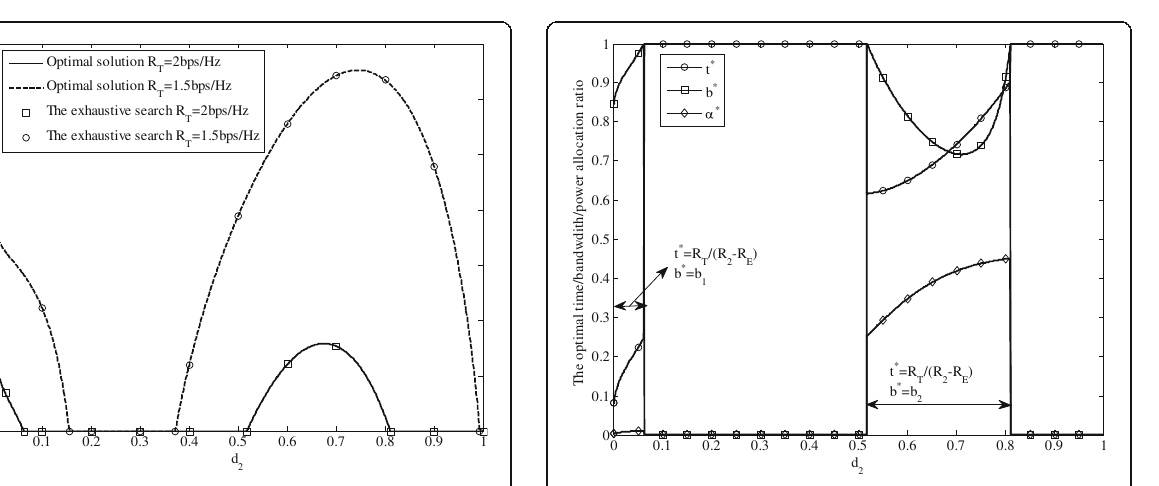
Fig. 2 Secondary user rate versus d 2 Fig. 3 The optimal time and bandwidth allocation versus d